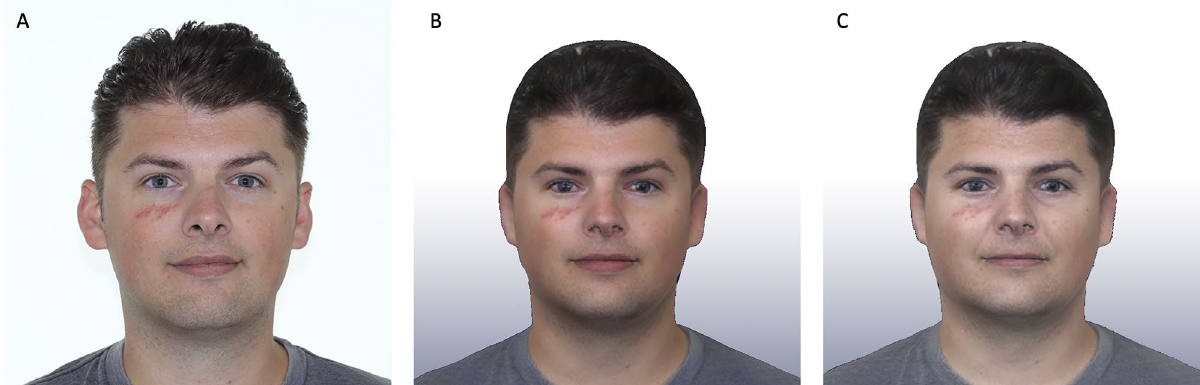
Figure 2. Avatar creation process. ( A ) Source image; ( B ) digital avatar version reflecting present self; ( C ) aged avatar version reflecting Future Self. Informed consent was obtained from the participant for publishing their